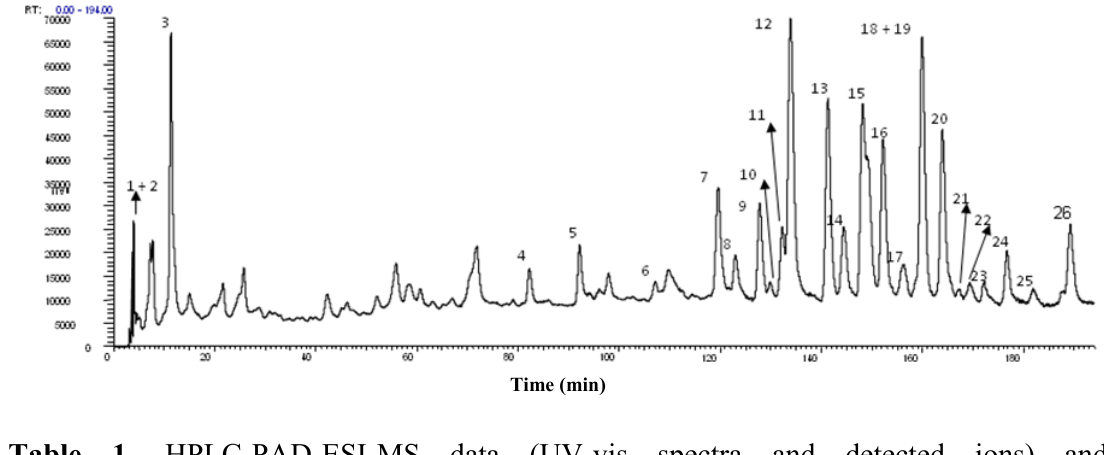
Table 1. HPLC-PAD-ESI-MS data (UV-vis spectra and detected ions) and FIA-ESI-IT-MS/MS n (product íons) of compounds detected in EtOH 70% leaves extract of Myrcia bella .